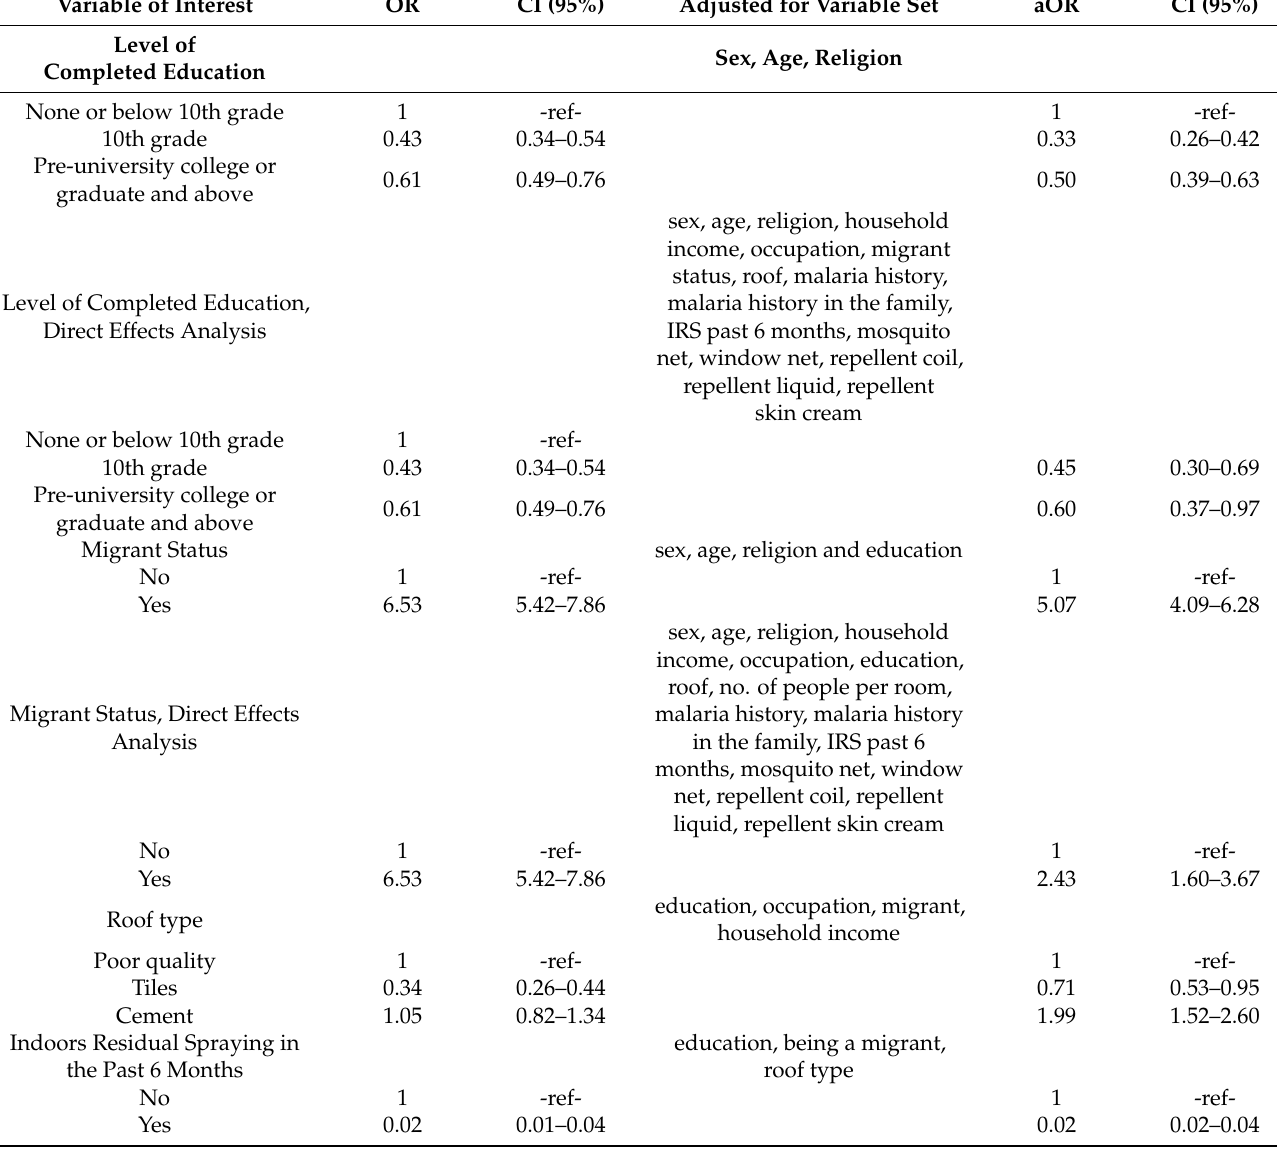
Table 2. Effect estimates for malaria in Mangaluru,